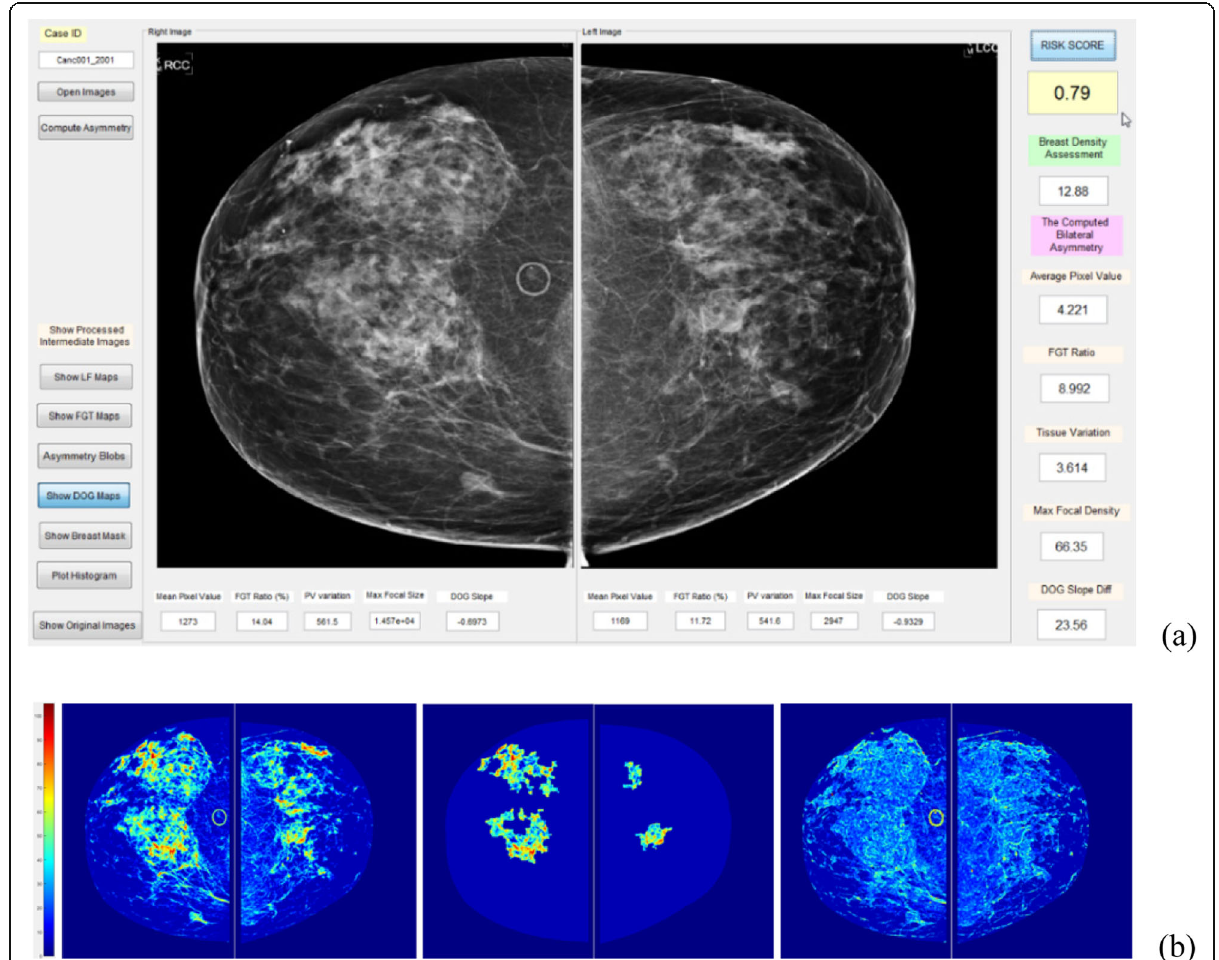
Fig. 1 The GUI of a CAD-based short-term breast cancer risk model ( a ) and bilateral asymmetry of dense tissue regions, local focal regions, and local pixel value fluctuation maps from the left to right ( b